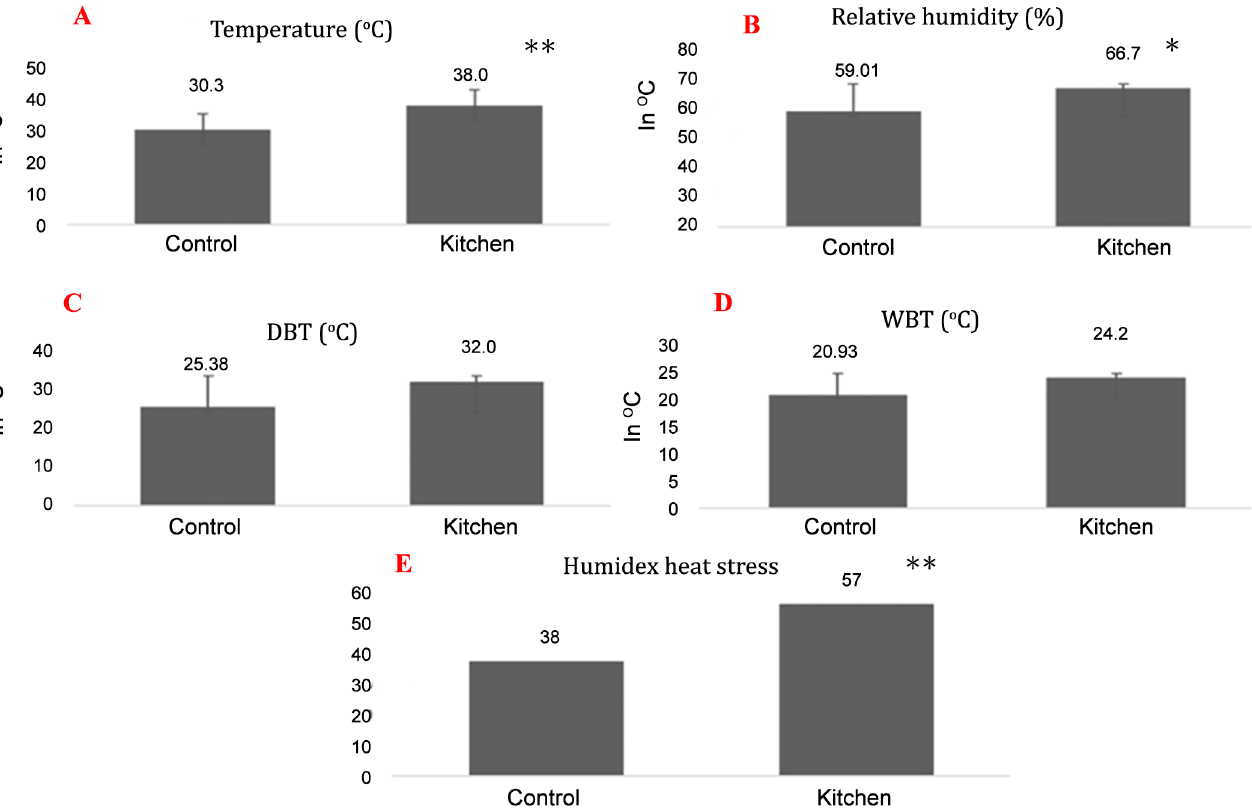
Fig 1. Humidex heat stress at kitchen and control room. (A) Temperature [Normal range: 20 – 27°C [28]; (B) Relative Humidity (%) [Normal range:30 – 60% [28]; (C) Dry bulb temperature (DBT); (D)Wet bulb temperature; (E) Humidex heat stress difference at control room and kitchen [Normal range: < 29 [27]; * (p,0.05); ** (p,0.001).